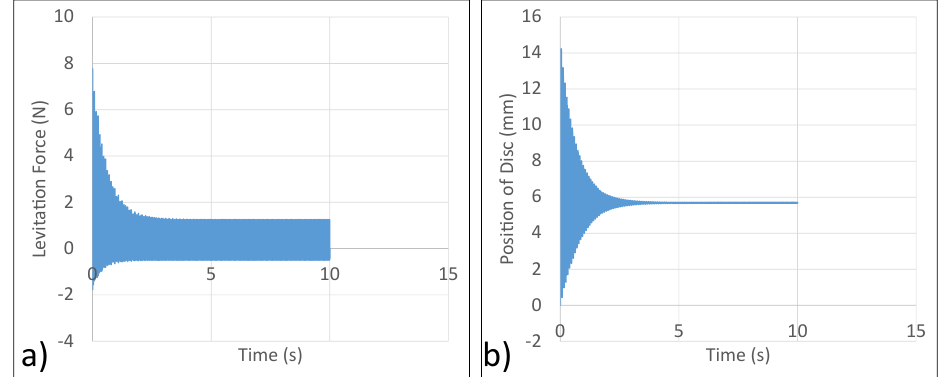
Figure 11. Simulation result with the resistor in parallel ( a ) Levitation force vs. time—with resistor in parallel. ( b ) Position of disc vs. time—with resistor in parallel.